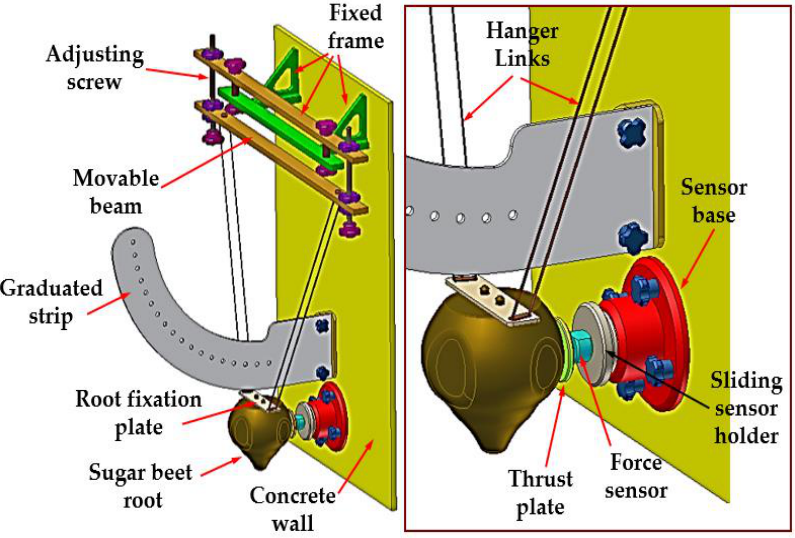
Figure 1. Scheme of the stand for the impact tests of sugar beet roots. The roots were fixed to the plate with screws of large-pitch thread. Due to a much smaller mass of hanger links compared with the root mass, it can be stated that the beet mass is decisive for the value of inertia moment calculated in relation to the rotation axis of these elements. The force sensor was connected to the movable holder and placed in the concrete wall base. The connection was blocked by the screw grip. The shift of holder in the package ensured regulation of root position in relation to the sensor so that the force at the time of impact had a horizontal direction. The resistance plate was fixed to the force sensor. A suitable beet root setting was possible using the regulating screws in the movable